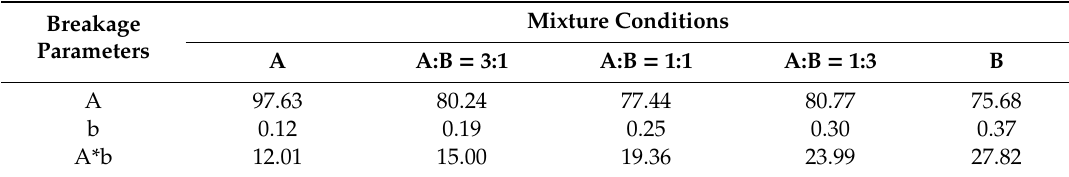
Table 2. Breakage parameters of mixtures.